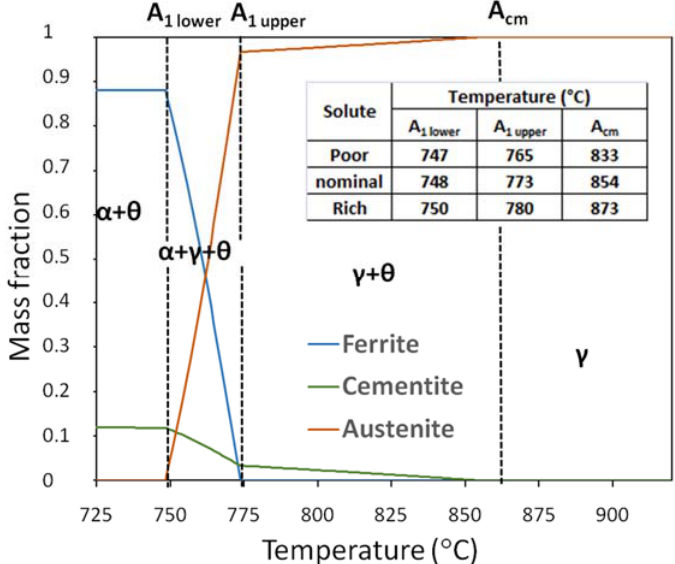
Figure 7. Temperature evolution of the mass fraction of the ferrite ( α ), austenite ( γ ) and cementite ( θ ) phases for the nominal composition. Simulations performed using the Thermocalc ® software. Assuming quasi-equilibrium heating conditions A1- lower and A1- upper would set the start and end of ferrite into austenite transformation. A CM sets the temperature at which cementite dissolution is complete and a fully austenitic microstructure is obtained. The inset provides a table with the transformation temperatures for the three EMPA compositions (Table 2).